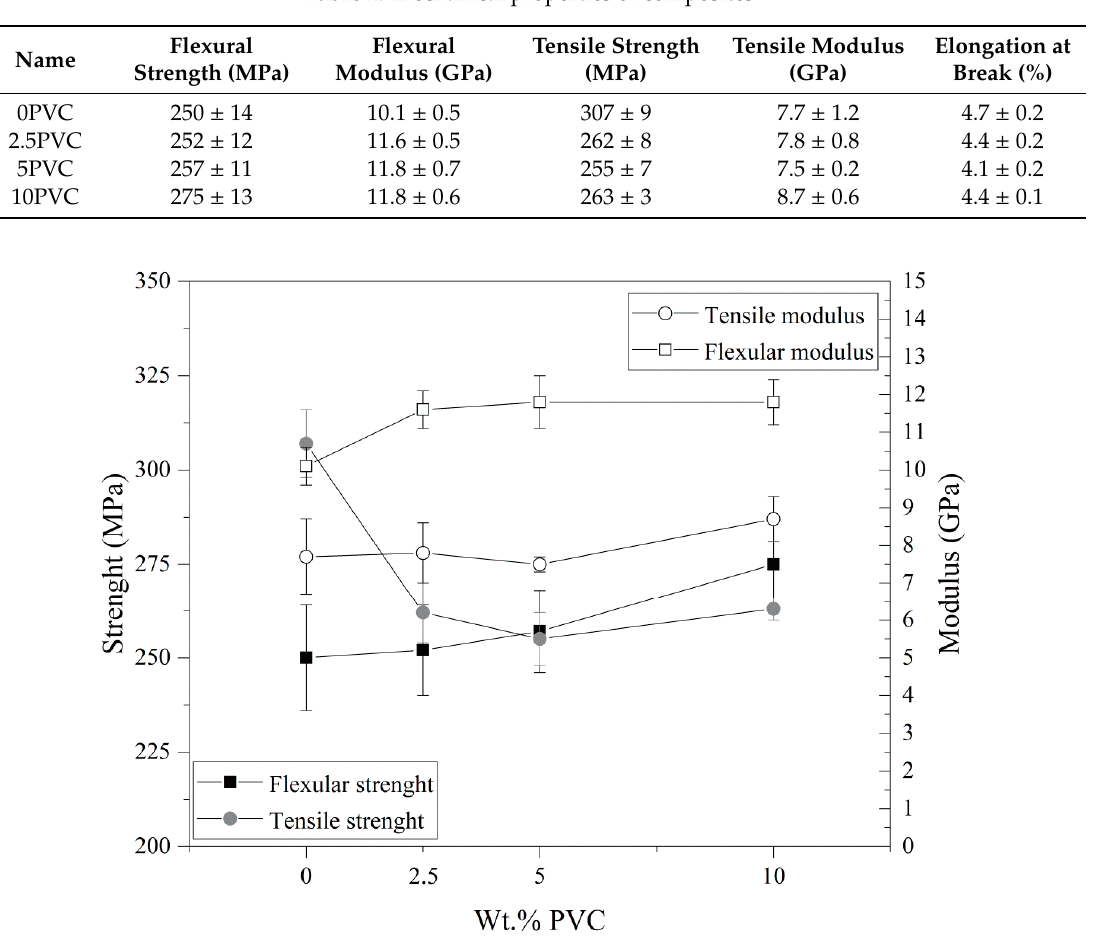
Figure 4. Mechanical properties of the composites.